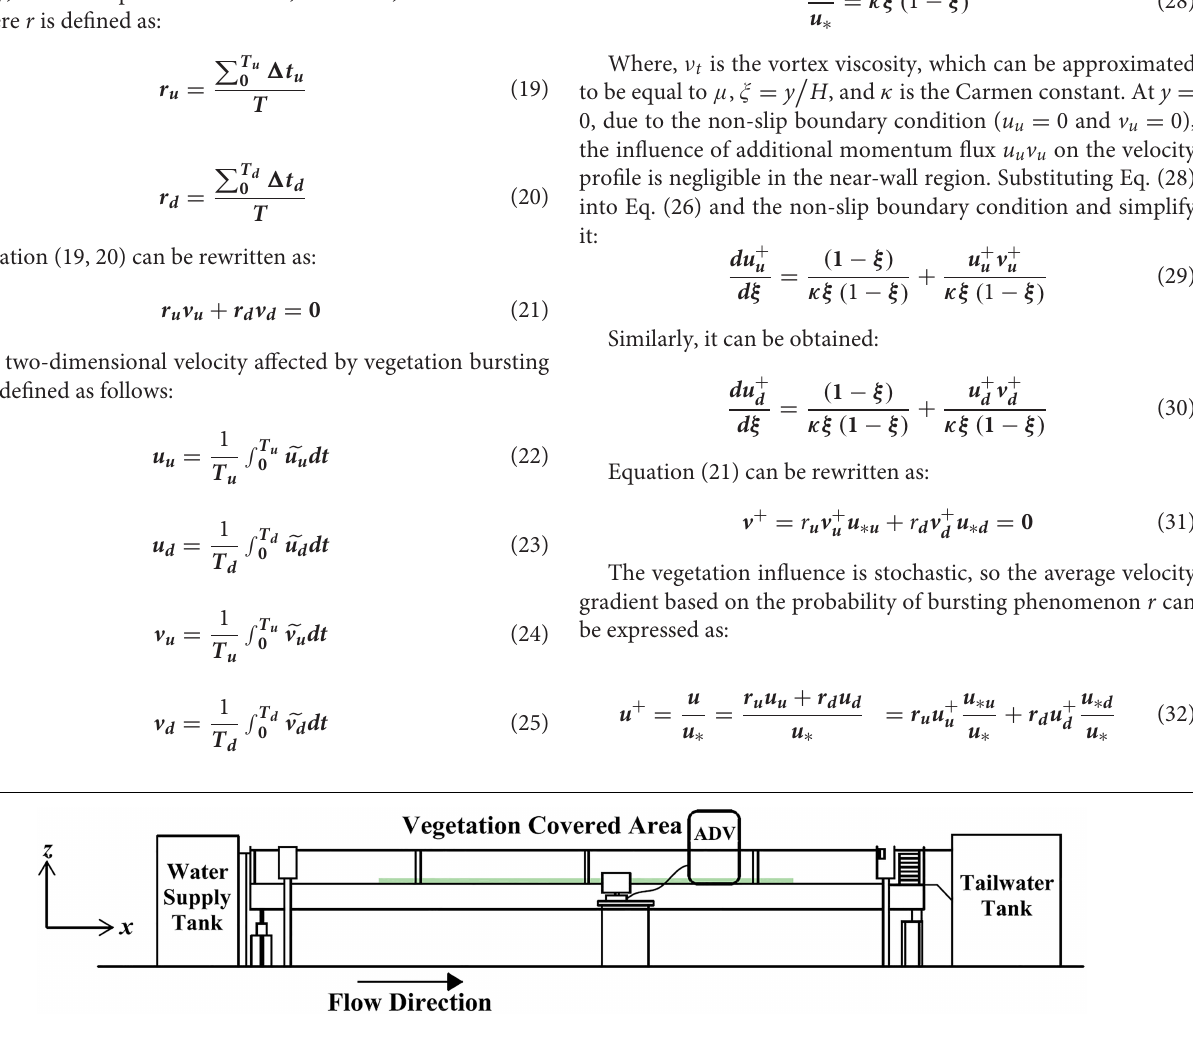
FIGURE 1 | Experimental platform for physical model of ecological